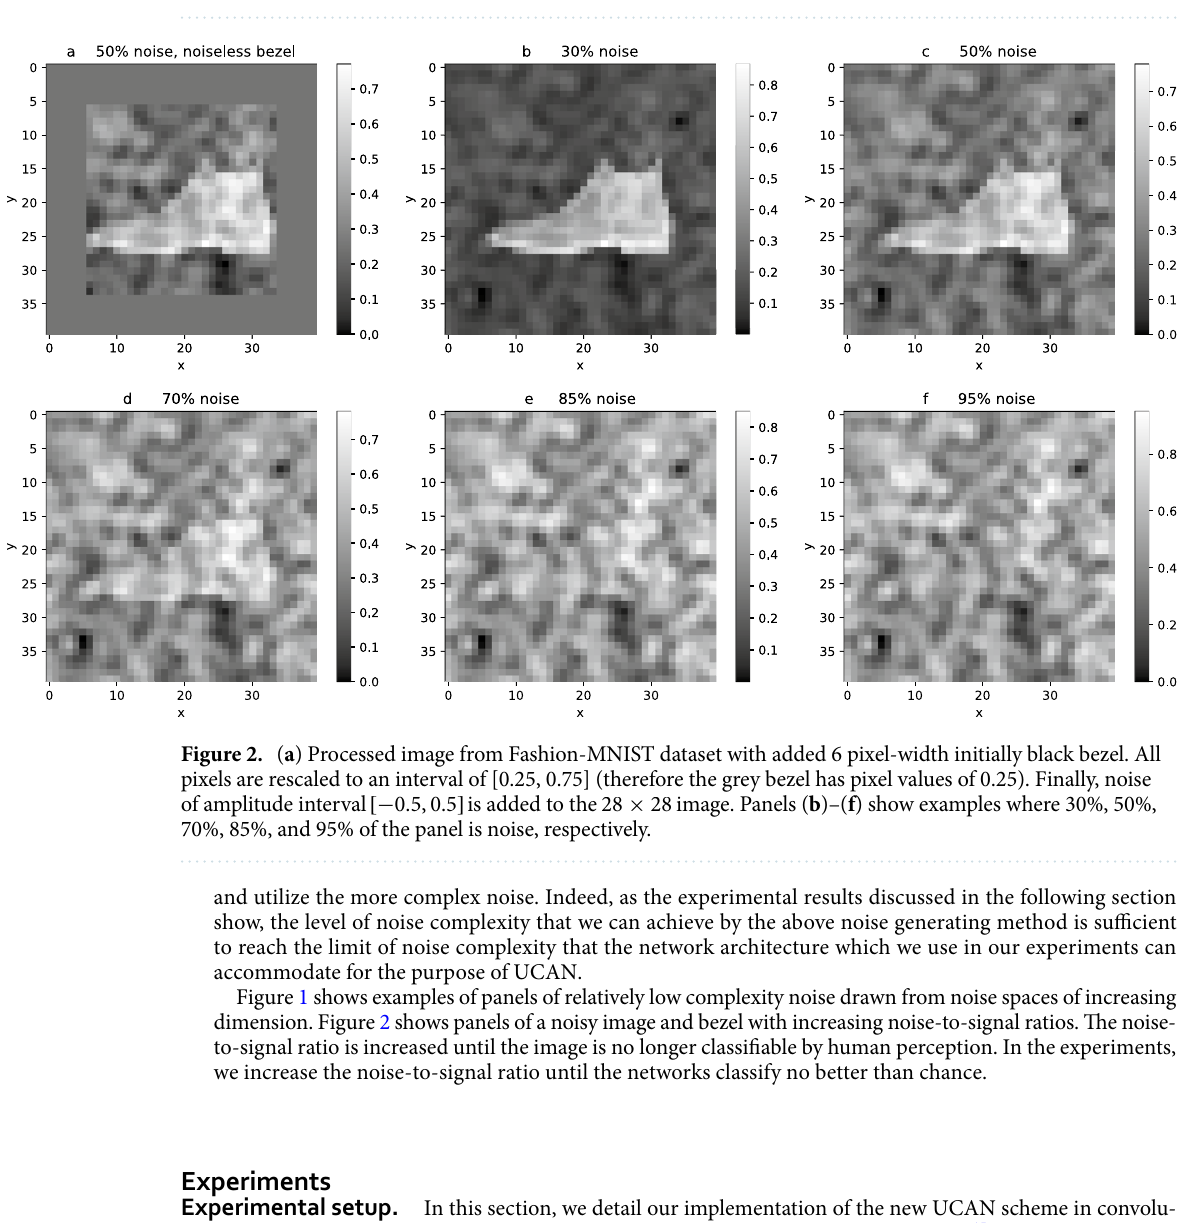
Figure 1. Examples of low complexity noise panels drawn from noise spaces of dimensions ( 5 × 5 ) , ( 15 × 15 ) , and ( 22 × 22 ) respectively.